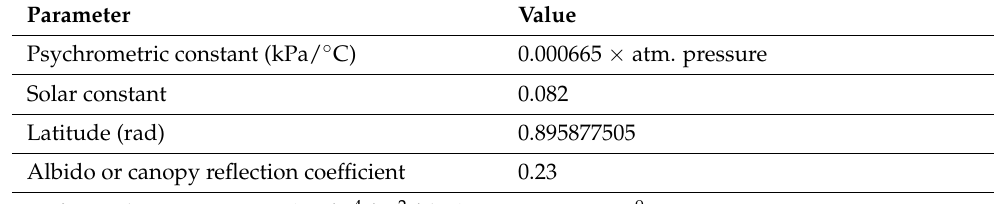
Table 2. Parameters used for the calculation of evapotranspiration.